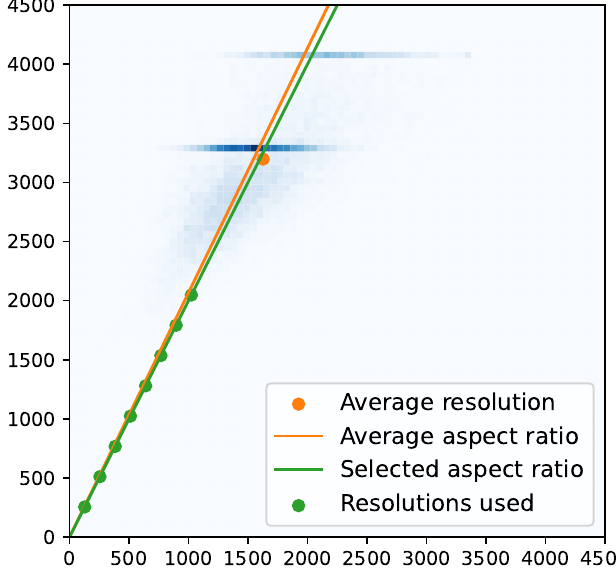
Figure 2. 2D histogram of image resolutions. The orange line and circle represent the average of aspect ratios and the ratio between average height and width, respectively. The green circles indicate the resolutions used in this